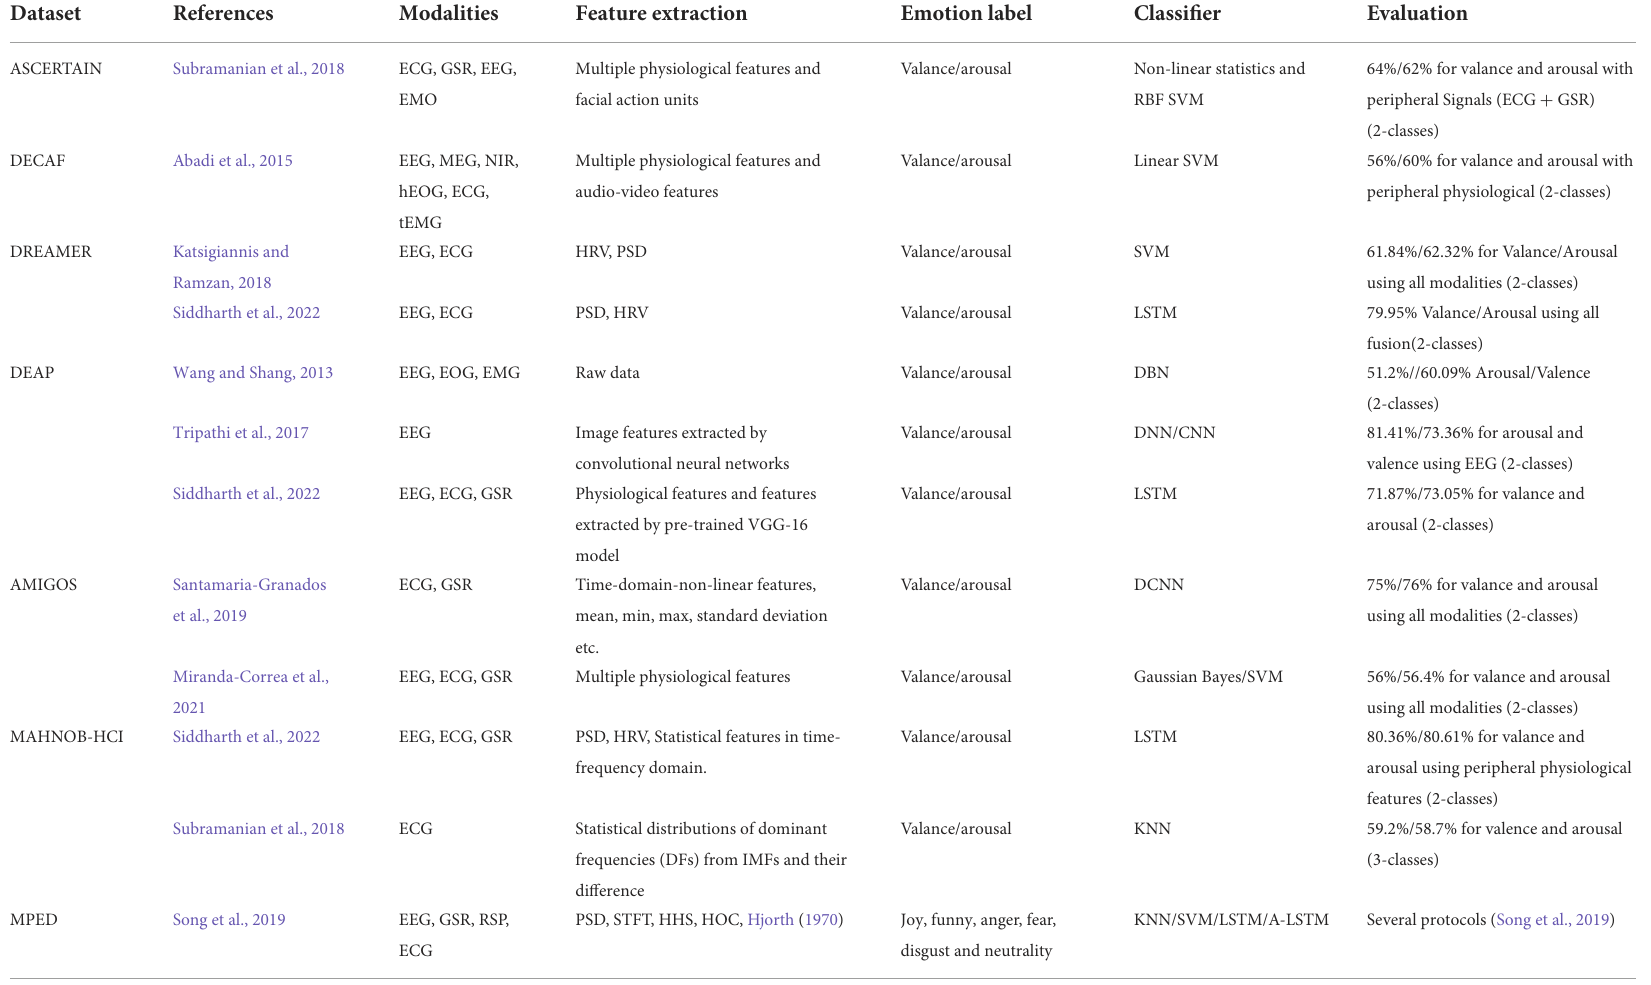
TABLE 1 Summary of the multi-modal physiological research using video